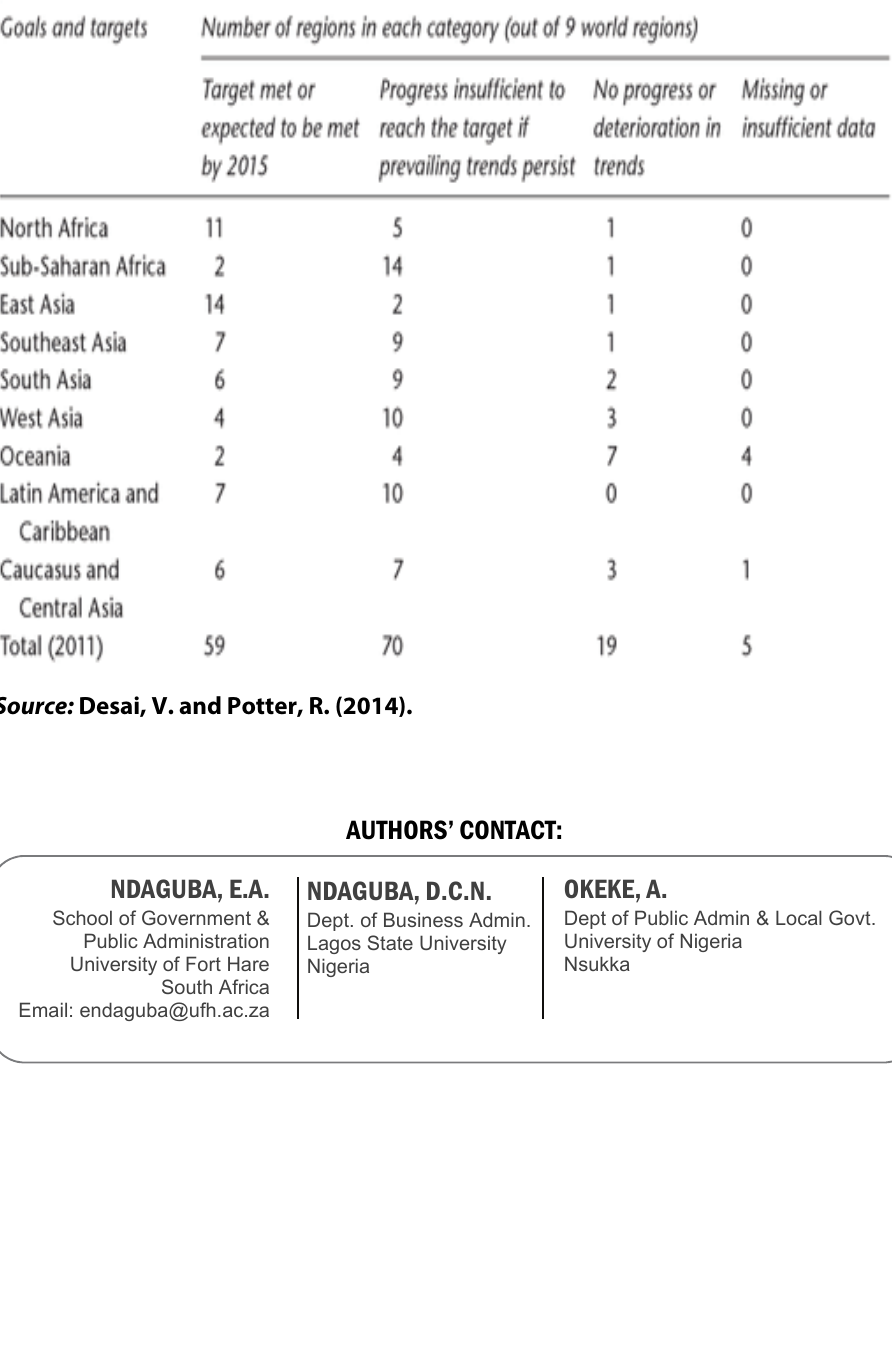
Draft figure: Progress chart by region